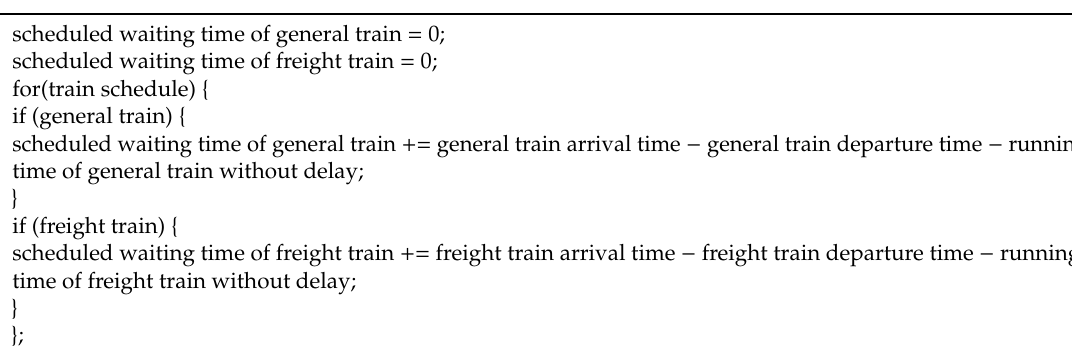
Table 8. Pseudocode for calculating the fitness [6].